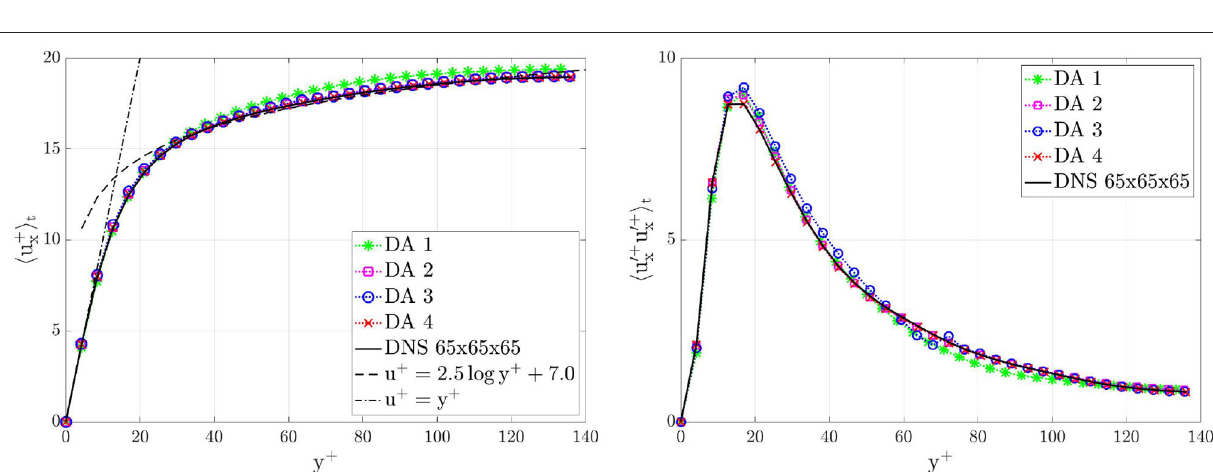
FIGURE 8 | Turbulent channel flow: h Re τ i t (left) and TKE ( t ) (right) evolution over time obtained by using data acquired from different windows.